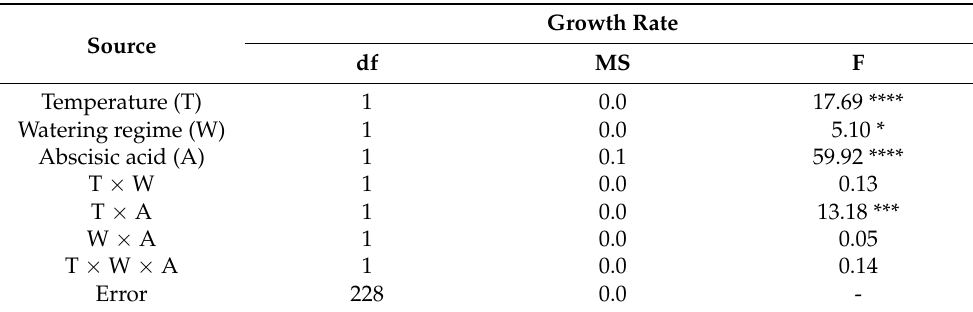
Table 3. Analysis of variance for the effects of temperature, watering regime, abscisic acid, and their interactions on growth rate of tomato plants.